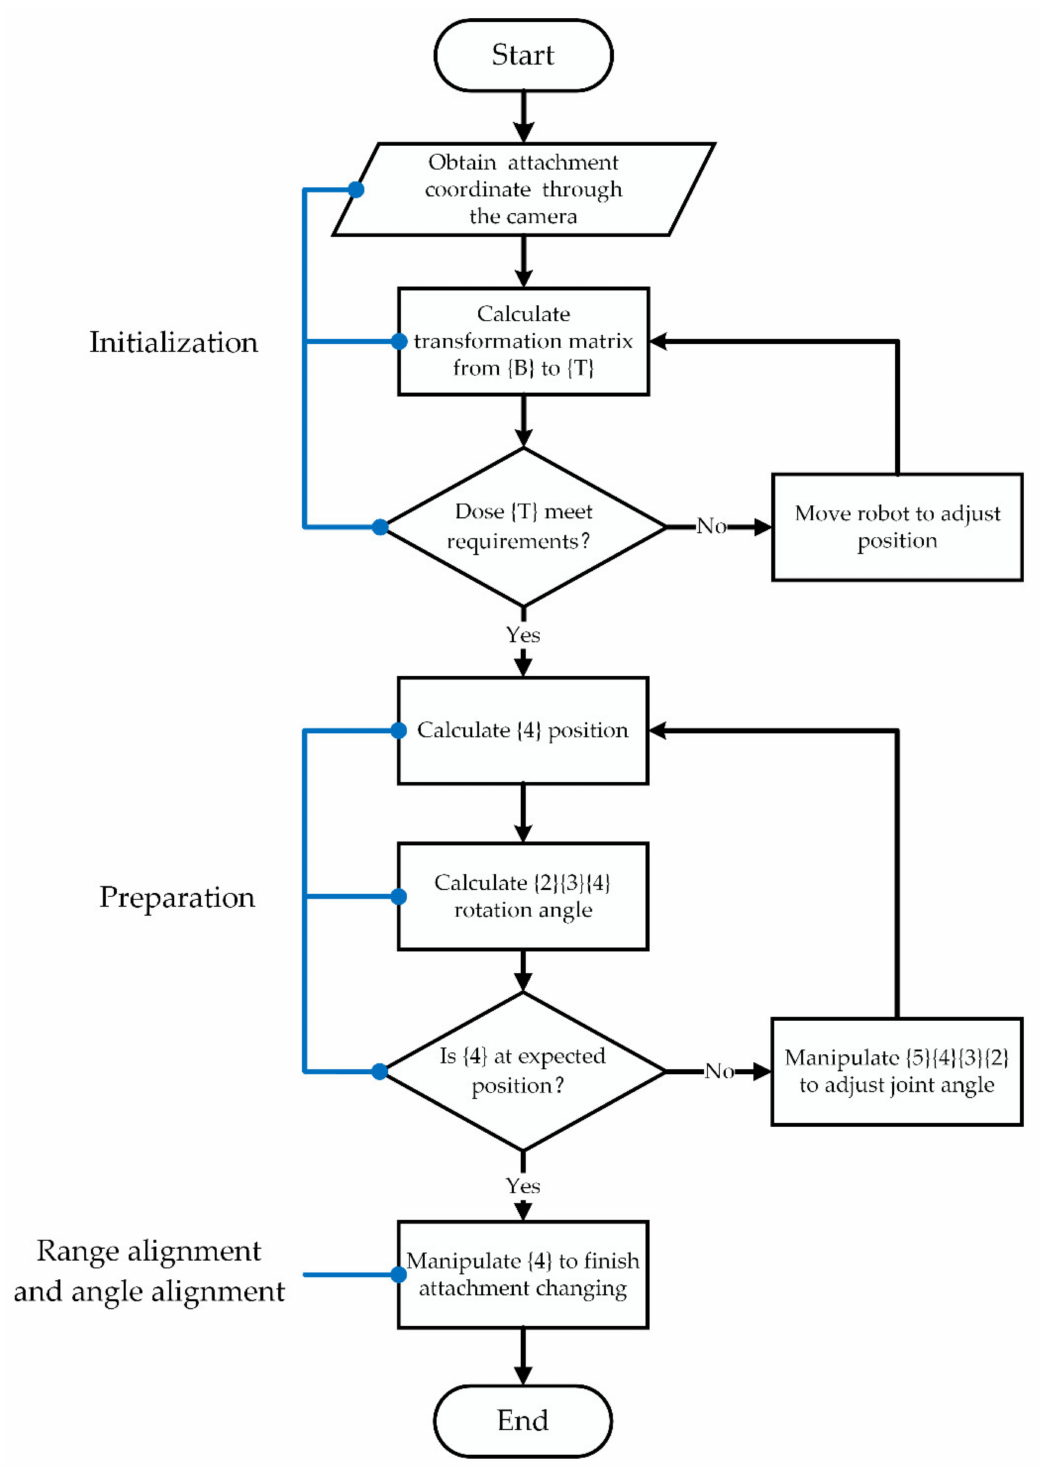
Figure 8. Block diagram of attachment changing trajectory